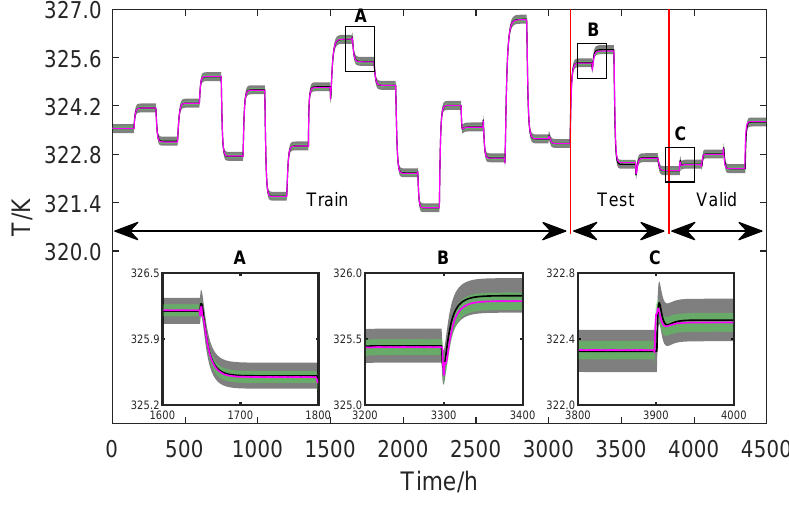
Figure 13. Training and validation data of T